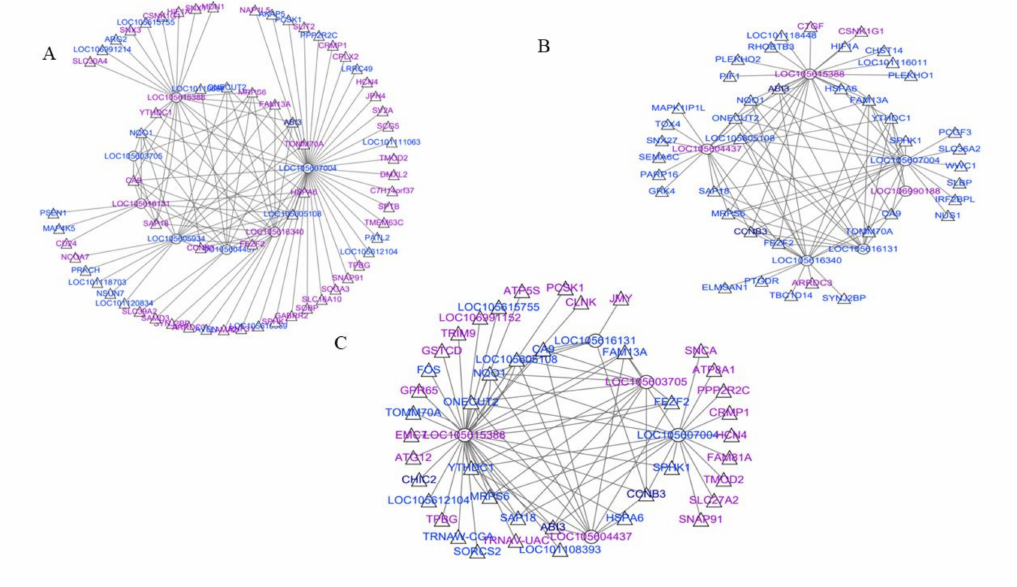
Figure 6. The interaction networks were identified for lncRNAs and their corresponding target genes. ( A ) The networks for SP42 and LP42; ( B ) the networks for SP42 and SPLP42; ( C ) the networks for LP42 and SPLP42. Blue and purple represent up and downregulation, respectively. Triangle and Ellipse represent mRNAs and lncRNAs,